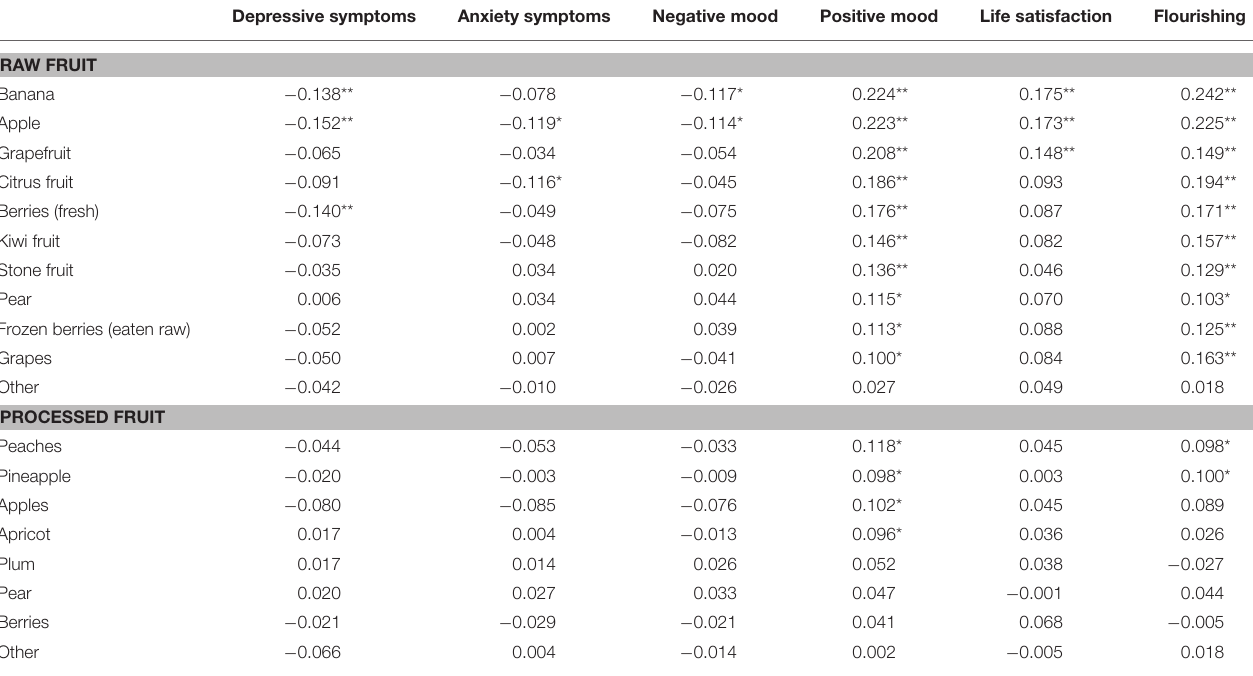
TABLE 7 | Correlations between types of raw and processed fruits, and mental health. Depressive symptoms Anxiety symptoms Negative mood Positive mood Life satisfaction